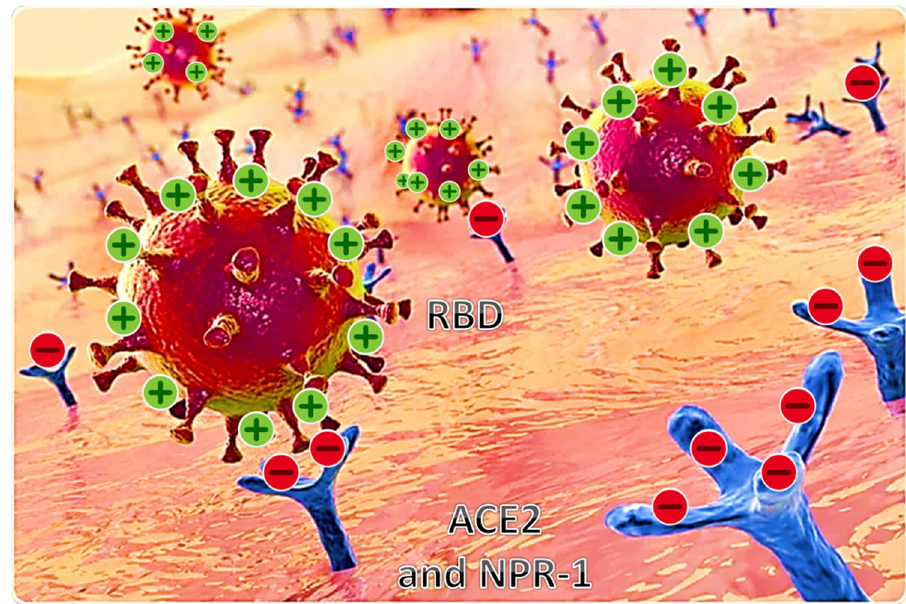
Figure 3: The N - terminal and CTDs of SARS - CoV - 2 S - proteins exhibit positive charges, while the human cells ( ACE2 ) and NPR - 1 have negative charges that could establish RBD – ACE2